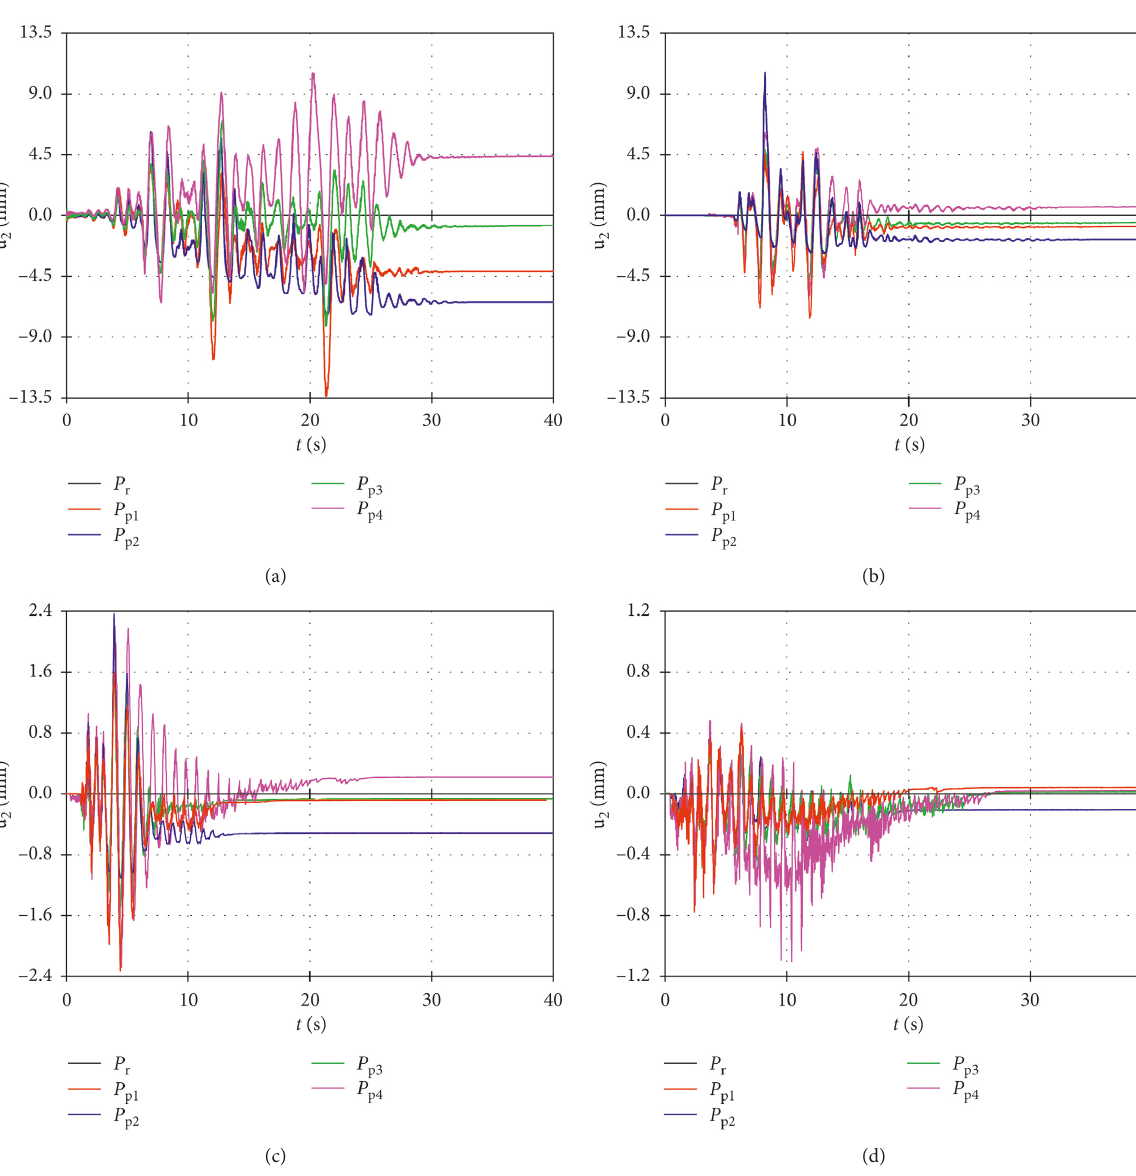
) for MSSB. (a) Artificial accelerogram (AA). (b) Accelerogram Petrovac (AP). 2